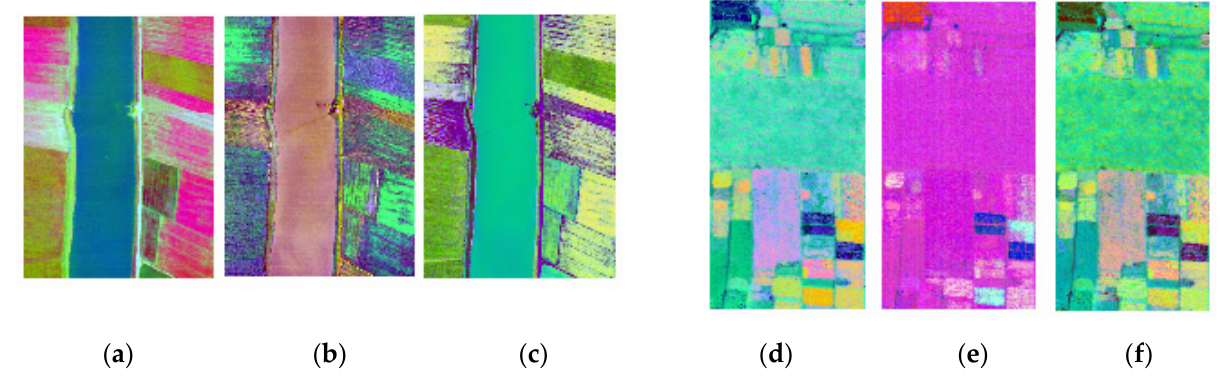
Figure 7. ( a – c ) Images of the Longkou area after MNF, ICA, and PCA transforms, respectively; ( d – f ) images of the Honghu area after MNF, ICA, and PCA transforms, respectively.